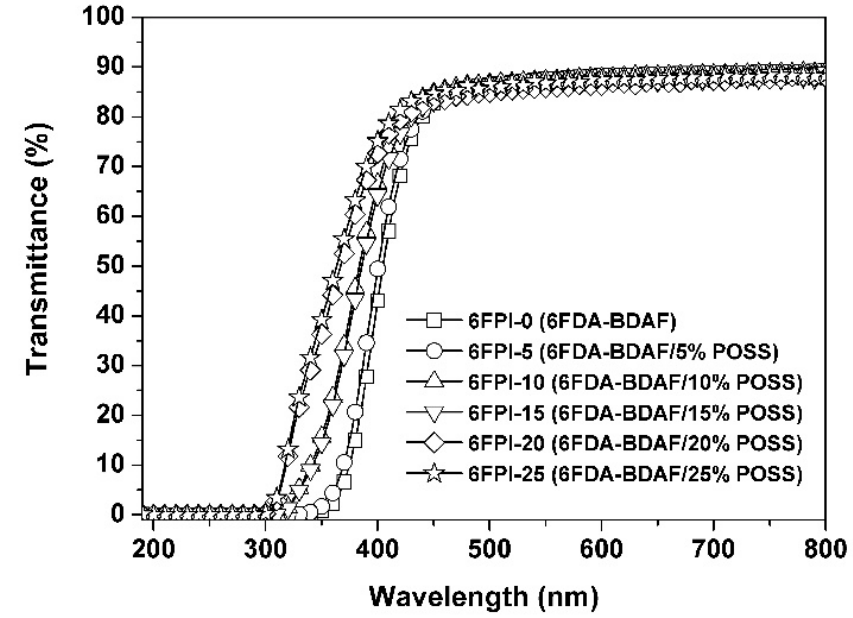
Figure 8. UV-Vis spectra of 6FPI-POSS composite films. Table 2. Optical and dielectric properties of 6FPI-POSS composite films.